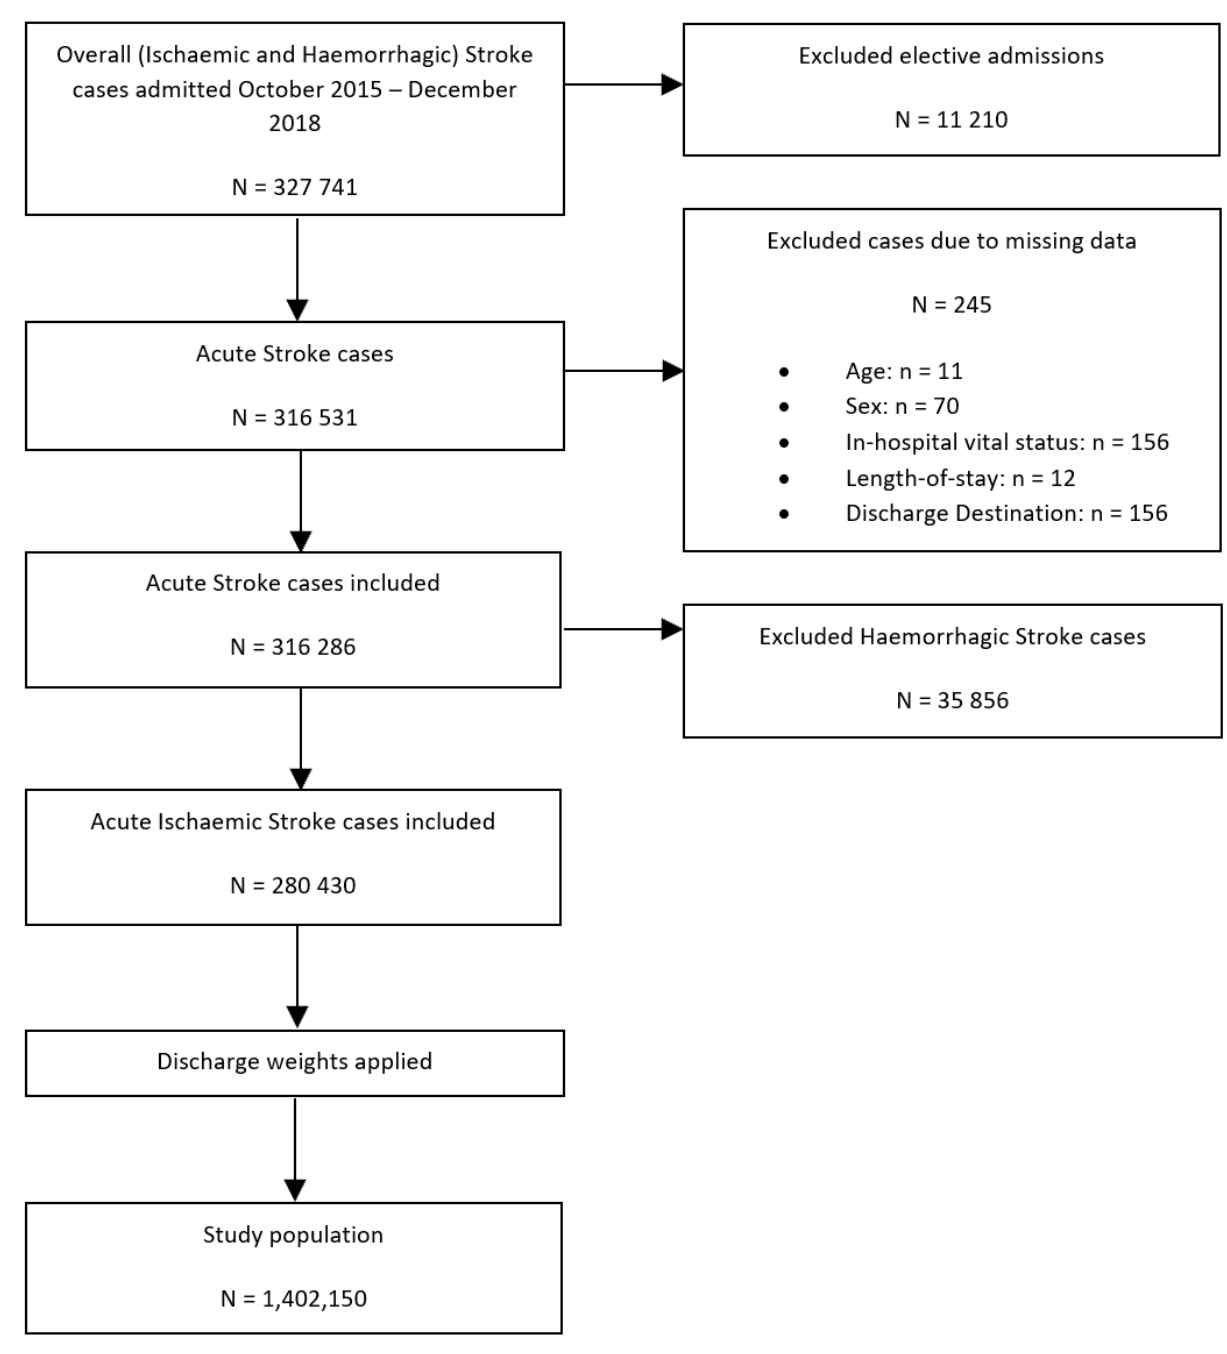
Figure 2. Patient population flowchart detailing the cohort included in the secondary analysis assessing the association between co-morbid SLE and IVT/ET receipt of intravenous thrombolysis or endovascular thrombectomy amongst patients with ischaemic stroke.